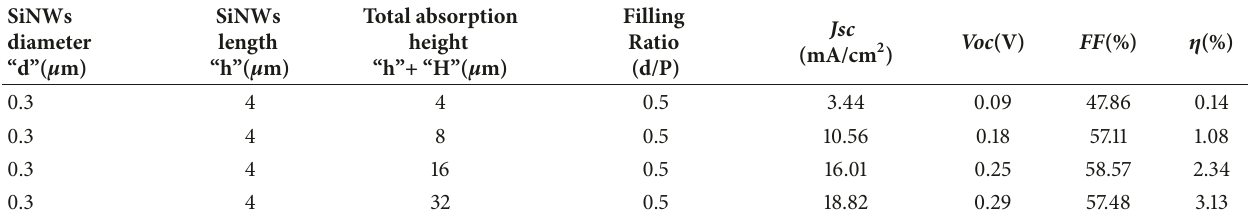
Figure 7: Photovoltaics performance of nanowires radial p-n junction solar cell: ( a ) J-V curves for total absorption versus different height; ( b ) 𝐽 𝑠𝑐 and 𝑉 𝑜𝑐 as a function of the absorber height with the same nanowire length. Table 2: Summary of device performance of nanowires core-shell solar